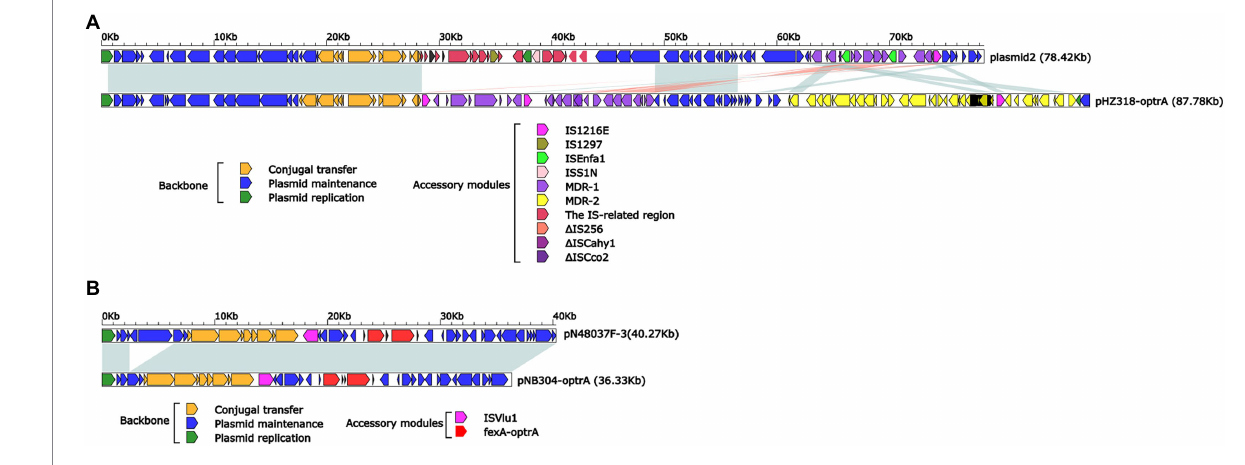
FIGURE 6 (A) Linear comparison of pHZ318-optrA and plasmid2. (B) Linear comparison of pNB304-optrA and